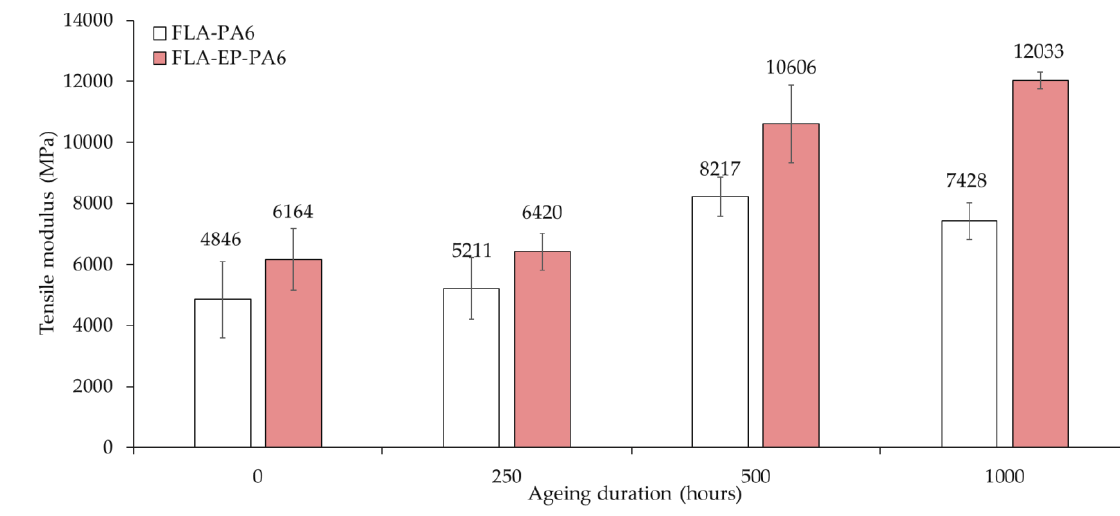
Figure 7. Tensile modulus of the biocomposites at ambient conditions.